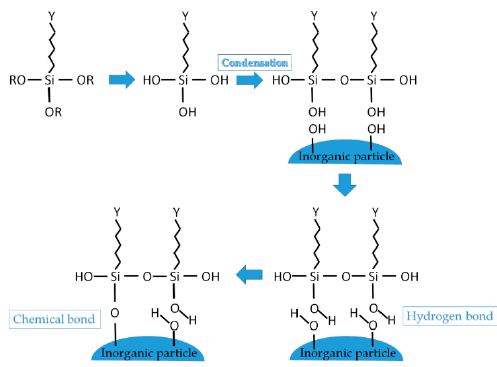
Figure 5. Schematic representation the surface functionalization of inorganic particles via condensation reaction of functional silanes (Redraw and adapted figure from [69]).